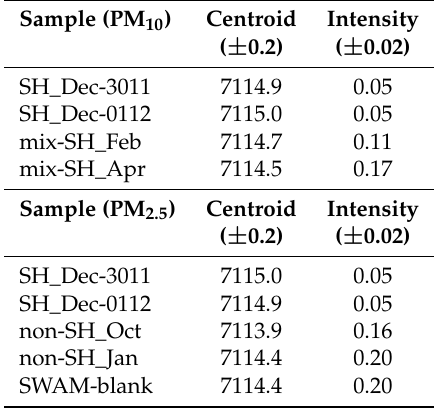
Table 2. XANES pre-edge features fit results for HVS PM 10 (upper panel) and PM 2.5 (lower panel) samples. Sample (PM 10 ) Centroid Intensity